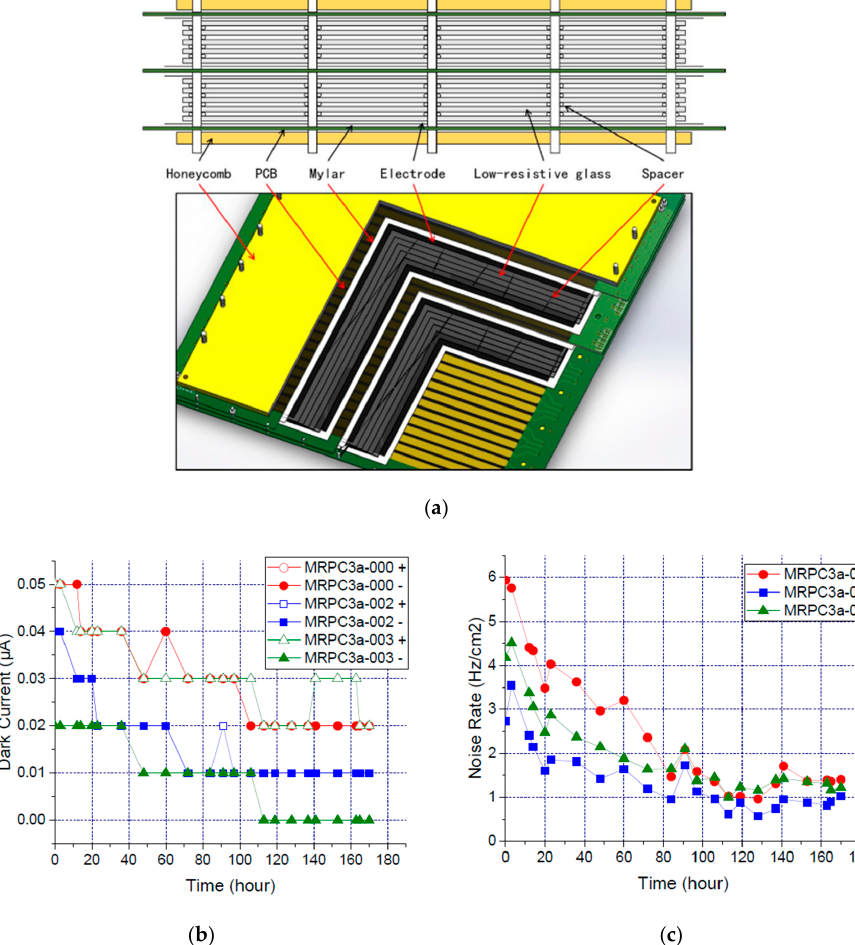
Figure 7. ( a ) The structure of the compressed baryonic matter spectrometer (CBM)-ToF MRPC. The dark current ( b ) and noise rate ( c ) recorded after applying the HV (high voltage). Reproduced with permission from Lyu et al., Journal of Instrumentation; published by IOP Publishing for Sissa Medialab, 2019 [71].